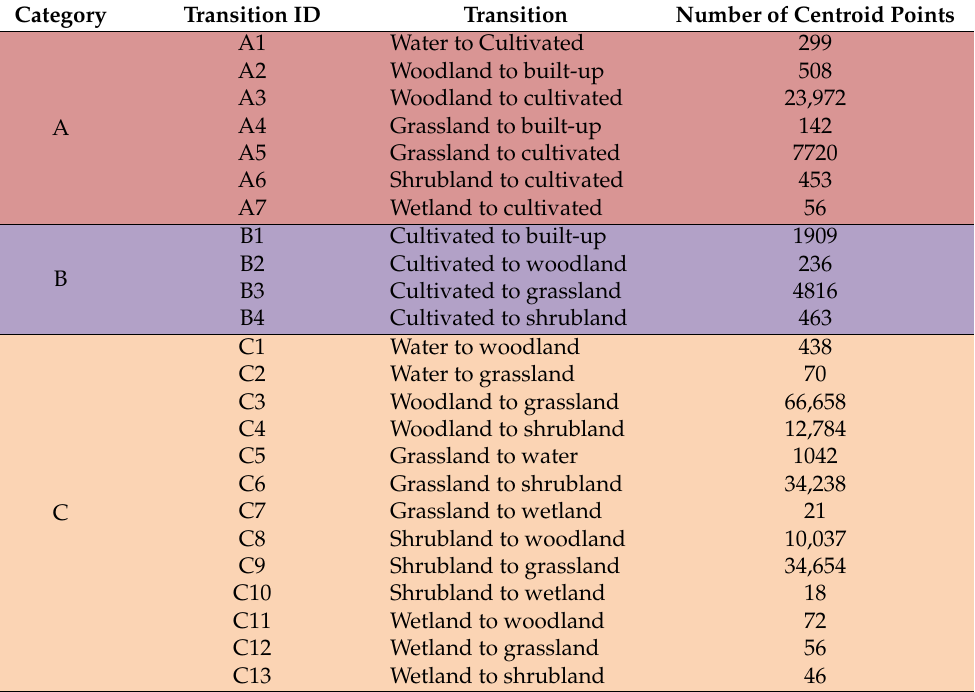
Table 1. Shows a summary of categories of LULC transitions based on initial class and final class where Category A have transitions from natural classes to artificial classes, Category B have transitions from artificial classes to natural classes, and Category C have transitions from natural classes to another natural class—adopted from Kavhu et al.